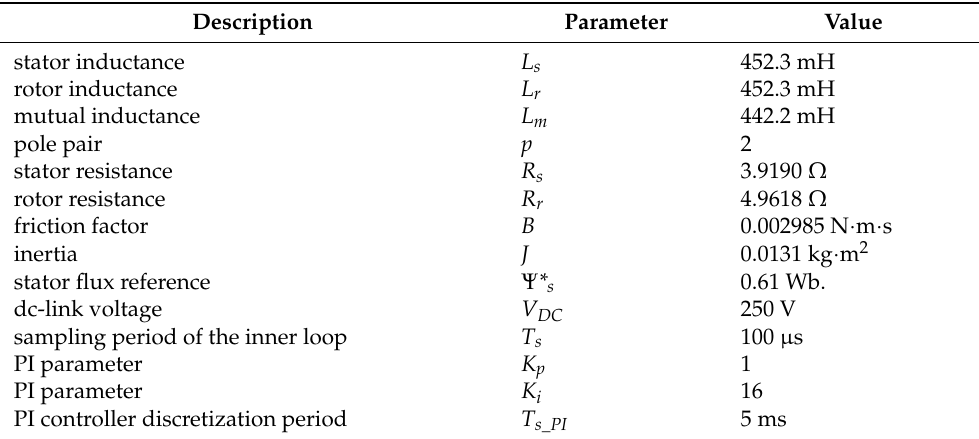
Table 2. System parameters.